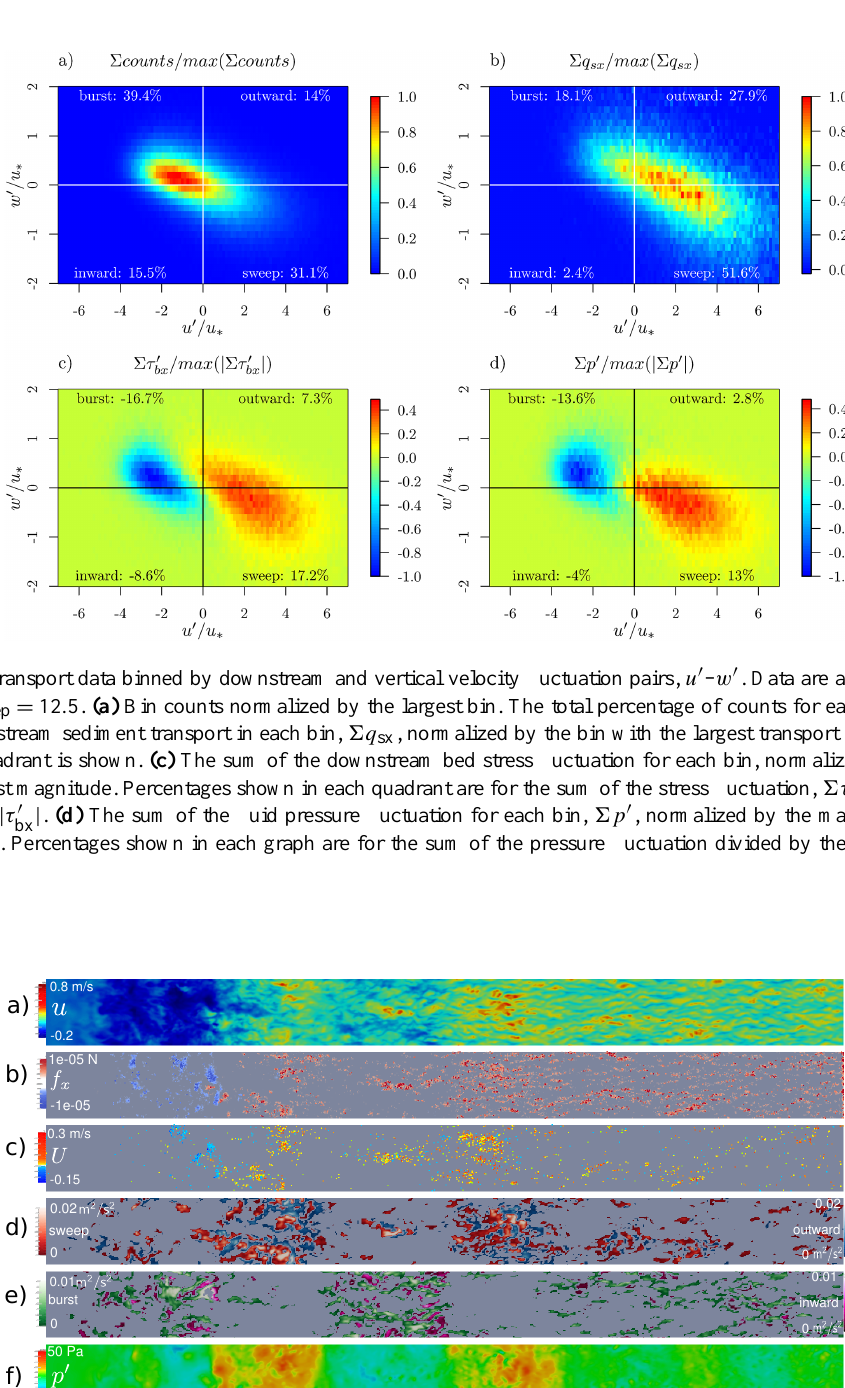
Figure 5. Flow, velocity quadrant, and transport variables at a time instant. (a) Downstream velocity at z = 1mm as shown in Fig. 1. (b) Downstream force, f x , on particles. Particles with | f x | < 2 × 10 − 6 N are not shown. (c) Downstream particle velocity. Particles with | U | < 0.007ms − 1 are not shown. (d) Sweeps and outward interactions at z = 5mm. Areas with | u (cid:48) w (cid:48) | < 0.0004m 2 s − 2 are not shown. (e) Bursts and inward interactions at z = 5mm. Areas with | u (cid:48) w (cid:48) | < 0 . 0004m 2 s − 2 are not shown. (f) Near-bed pressure fluctuation at z = 1mm as shown in Fig. 1. An animation associated with this figure can be found in the Supplement.